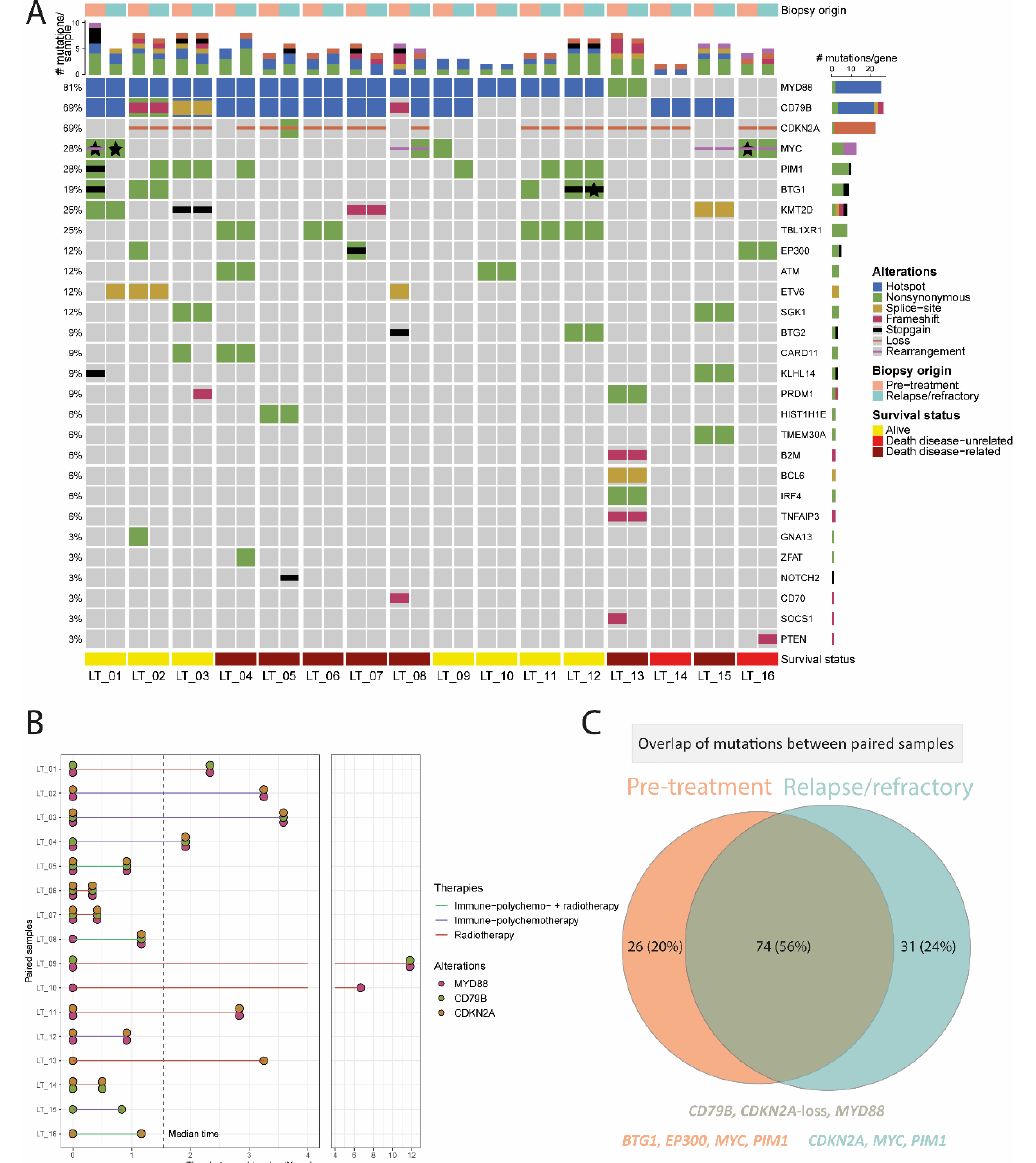
Figure 3. Paired molecular analysis of 16 patients with primary cutaneous diffuse large B-cell, leg type. ( A ) Side-by-side oncoprint of the molecular profile of pre-treatment and relapse/refractory samples. Each patient harboured at least one (hotspot) alteration in MYD88 , CD79B , or CDKN2A . One patient gained a loss of CDKN2A and another patient gained a CD79B hotspot mutation and loss of CDKN2A . The stars indicate the presence of the same mutation type (e.g., nonsynonymous) in the primary and relapse samples but affecting different parts of the gene. ( B ) Time between biopsies of the paired samples with a median time of 1.5 (range, 1.3–11.8) years. Half of the patients received immuno-polychemotherapy (three patients with and five patients without local radiotherapy, including one patient who received R-CEOP instead of R-CHOP). The remaining patients were treated with local radiotherapy without systemic agents. Only two out of the 16 patients had a shift in the three major drivers. ( C ) Overview of the unique alterations identified in primary and relapse cases and the overlap between both time points. Most of the genetic alterations (74/131; 56%) were stable over time, especially mutations in MYD88 / CD79B and loss of CDKN2A . Most of the mutations that were gained (31/131; 24%) affected CDKN2A , MYC , and PIM1 , and most of the mutations that were lost (26/131; 20%) affected BTG1 , EP300 , MYC, and PIM1 . Regarding the main driver alterations, the molecular profile of PCDLBCL-LT was stable between primary and relapsed disease for MYD88 in all cases (12/12; 100%), for